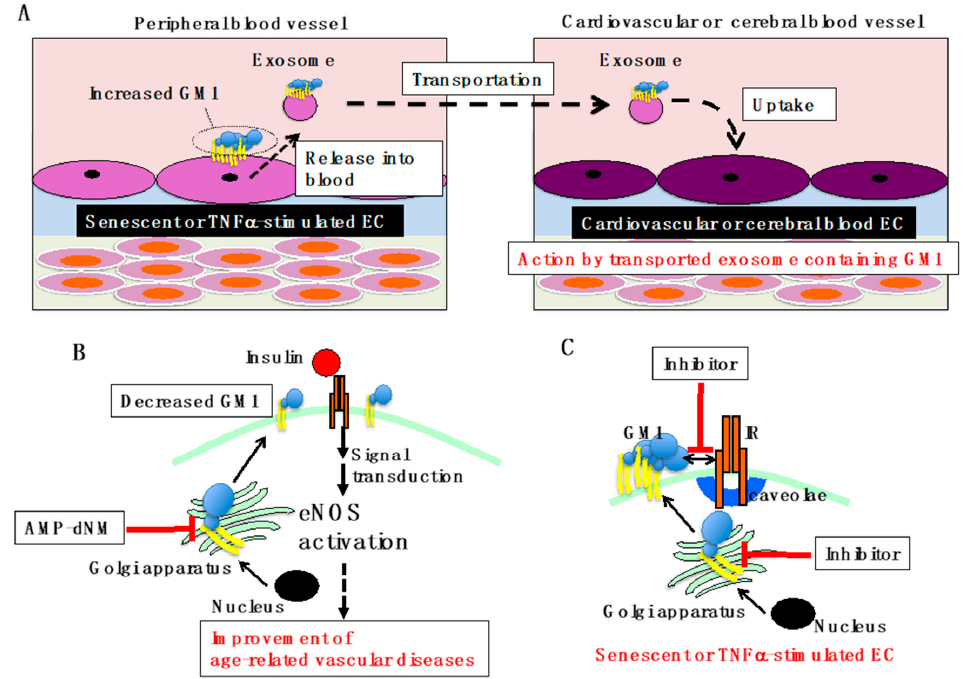
Figure 3. Overview of GM1-mediated vascular insulin resistance. ( A ) Proposed model for GM1-mediated vascular diseases. GM1, which is increased in ECs of peripheral blood vessels due to aging / senescence and inflammation, is secreted into blood vessels in exosomes. Exosomes containing GM1 are transported through blood vessels and incorporated by cardiovascular and cerebrovascular ECs. Vascular insulin resistance can be caused by GM1 taken up from the exosome, leading to insulin resistance-related diseases. ( B ) Improvement of age-related vascular diseases by AMP-dNM treatment. When AMP-dNM is administered, the GM1 increase in ECs associated with aging / senescence and inflammation can be suppressed. Most likely, insulin signaling can be restored, improving age-related vascular diseases. ( C ) GM1 specific inhibition for improvement of vascular insulin resistance. Specific inhibition of GM1 synthesis targeting B4GALNT1 or inhibition of the interaction between GM1 and IR in senescent and TNF α -stimulated ECs could be employed to develop new e ffi cient therapeutic strategies for vascular insulin